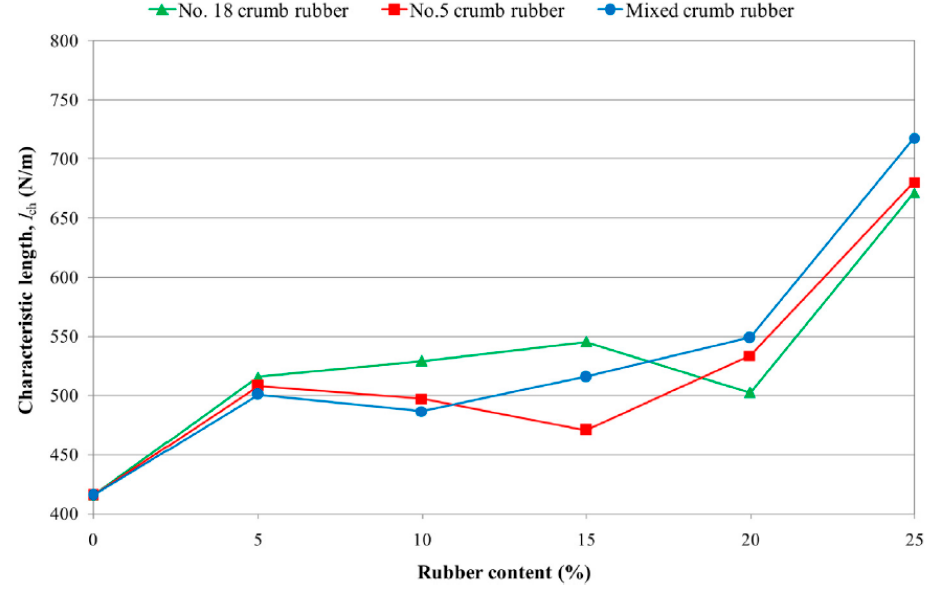
Figure 6. Relationship between characteristic length and rubber replacement level [36]. Reproduced with permission from Hilal, N.N. Hardened properties of self-compacting concrete with different crumb rubber size and content; published by Elsevier, International Journal Sustainable Built Environment, 2017.